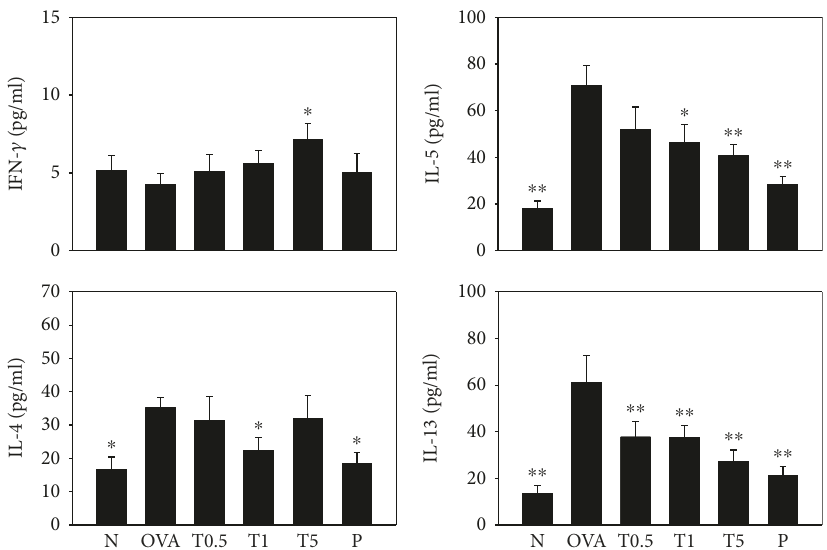
Figure 4: E ff ects of tomatidine on cytokine levels in bronchoalveolar lavage fl uid. The concentrations of IFN- γ , IL-4, IL-5, and IL-13 were measured by ELISA. All data are presented as means ± SEM. ∗ P < 0 05 , ∗∗ P < 0 01 compared to the OVA control